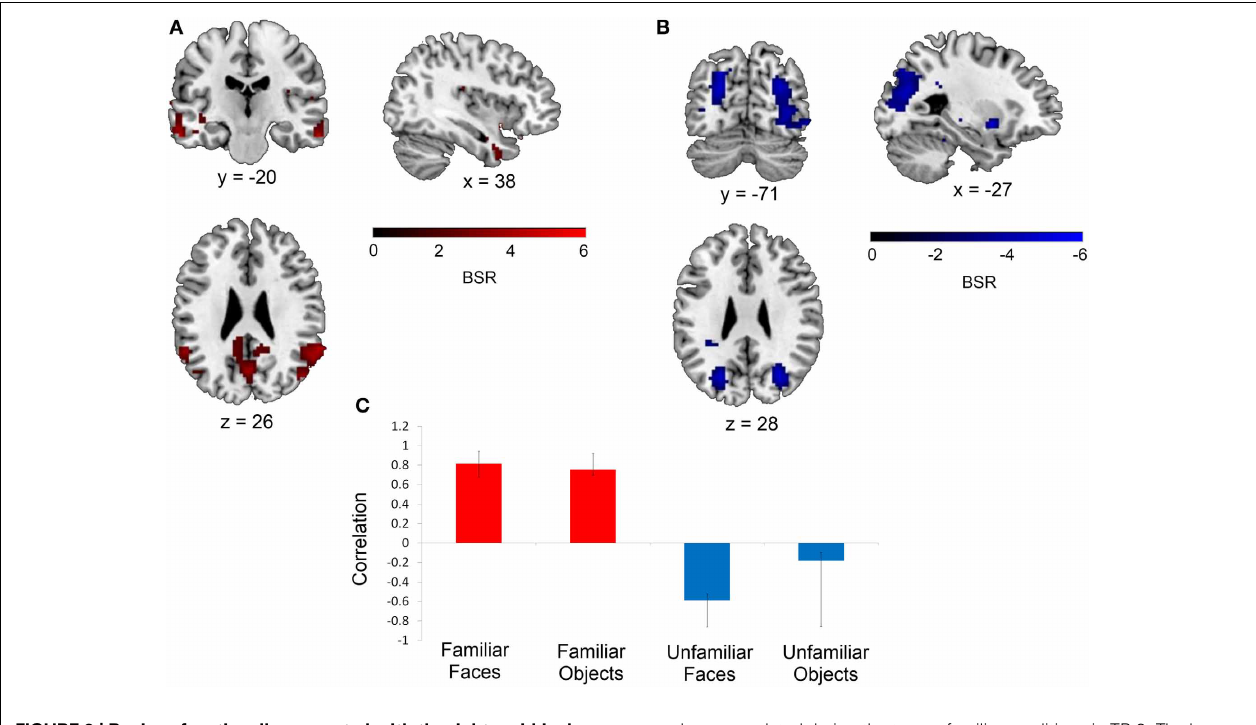
seed was correlated during the two unfamiliar conditions in TR 3. The bar graph in (C) depicts the correlation of the signal in the perirhinal seed with the two networks during the four experimental conditions. Maps are thresholded at the equivalent of p < 0 . 05 for visualization purposes, and networks are overlaid on the ch2bet template in MRIcron (Rorden et al., 2007). BSR, bootstrap ratio. Error bars reflect 95% confidence intervals.